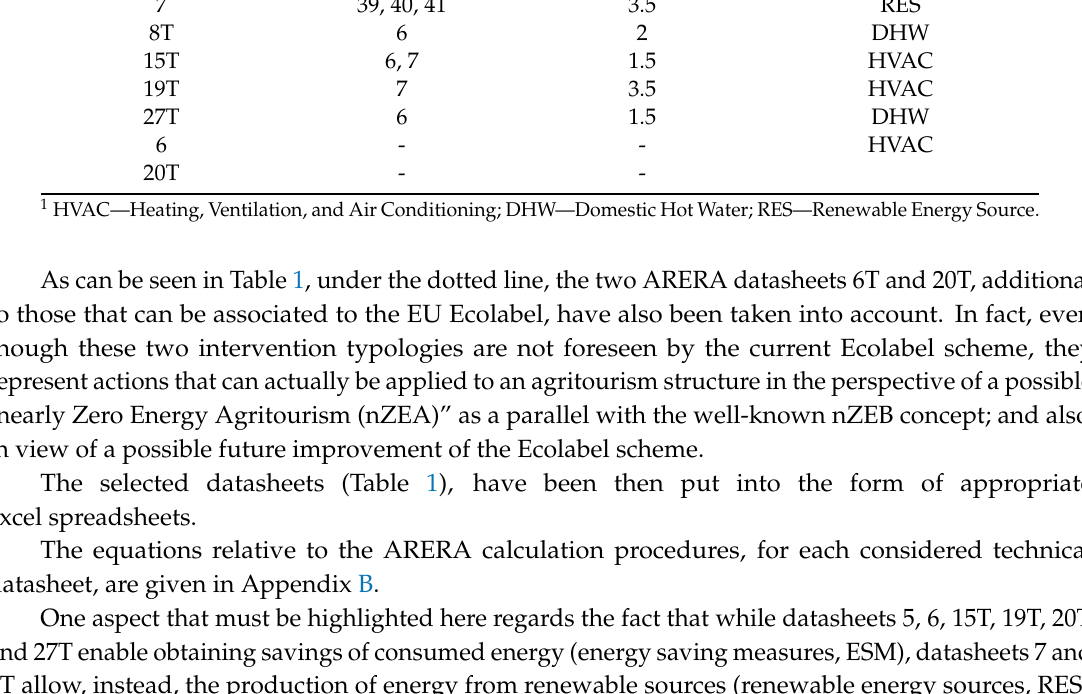
Table 1. Correspondence between the Italian Regulatory Authority for Energy Networks and Environment (ARERA) datasheets and the EU Ecolabel energy criteria. ARERA Technical EU Ecolabel EU Ecolabel Energy Consumption Data Sheet N. Criterion N. Achievable Points Category 1 5 33 4 HVAC 7 39, 40, 41 3.5 RES 8T 6 2 DHW 15T 6, 7 1.5 HVAC 19T 7 3.5 HVAC 27T 6 1.5 DHW 6 - - HVAC 20T -